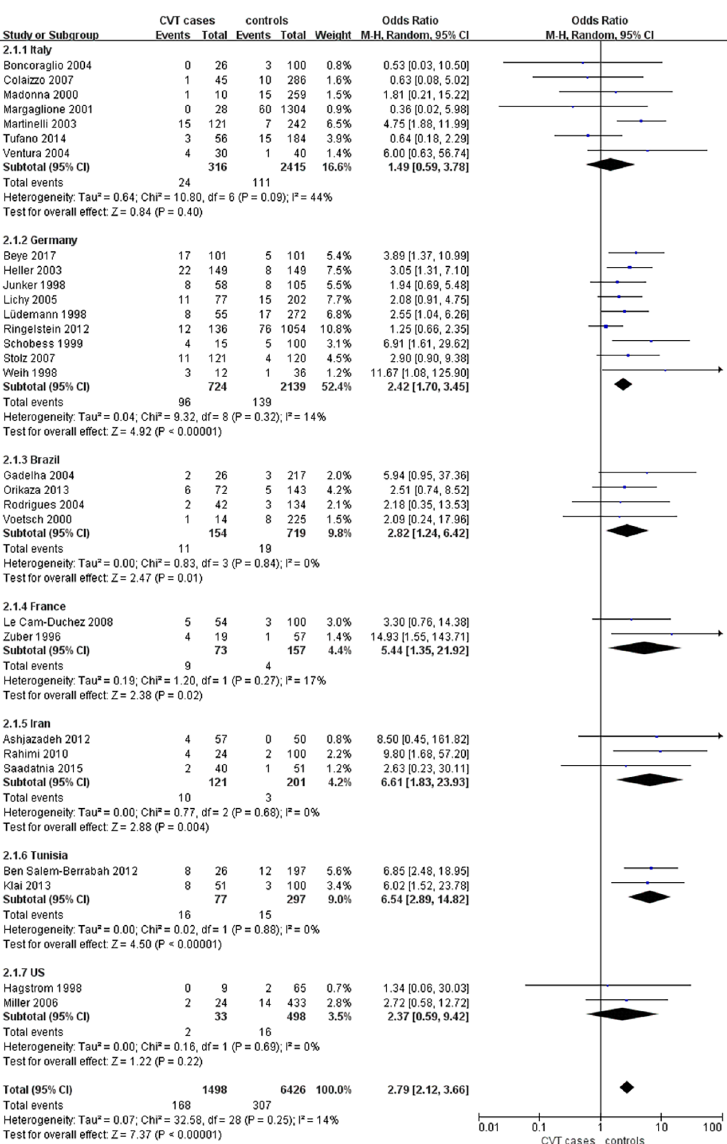
Fig 3. Subgroup analysis based on different countries. CI, confidence interval; CVT, cerebral venous thrombosis.